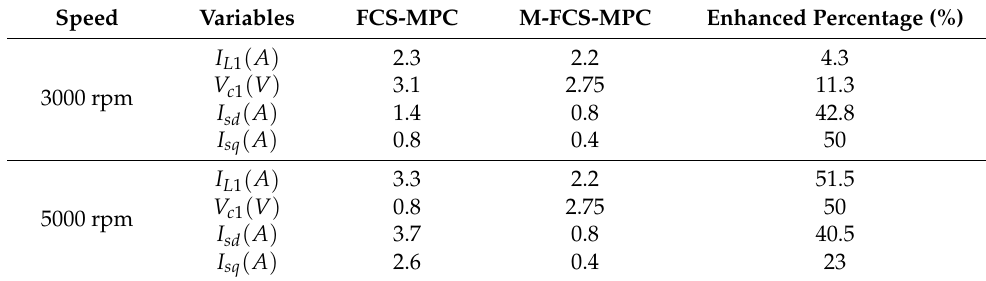
Table 4. Comparison in state-variable ripples with modulated and unmodulated